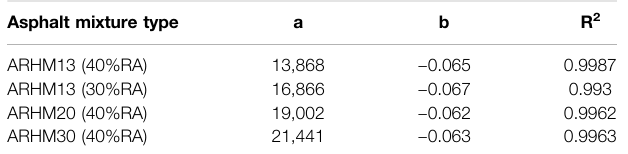
TABLE 3 | Correlation equation model parameters.